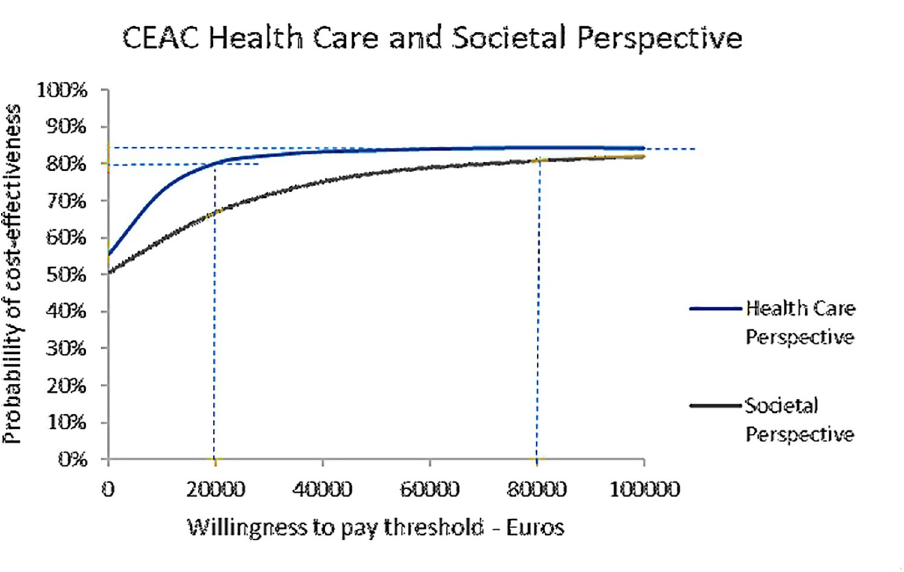
With regard to effectiveness in reducing anxiety symptoms, we found no significant differ- ences between bCBT and ftfCBT at post-treatment ( t = − 0.715, p = 0.477) nor at one-year fol- low-up ( t = 1.702, p = 0.093). Both groups exhibited moderate to large within-group effect sizes (range of d : 0.50 to 1.00). Moreover, no significant differences between the groups were found in terms of effects on depressive symptoms, general psychopathology, sense of control